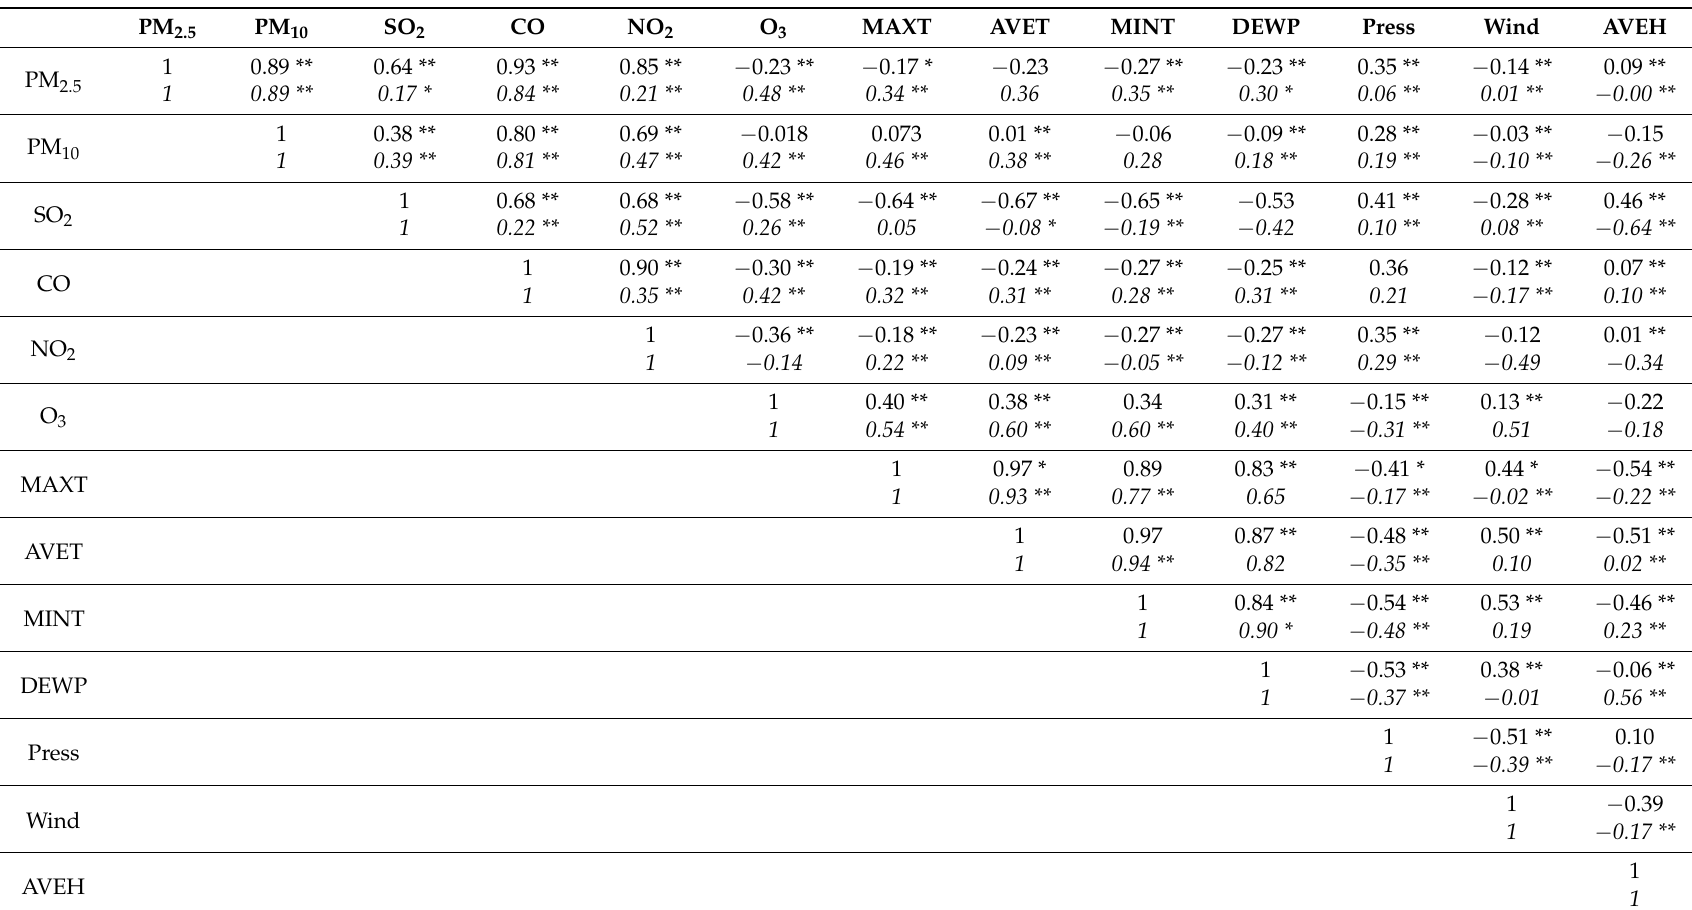
Table 2. Pearson’s correlation coefficients among environmental variables in cold season and warm season, Changchun